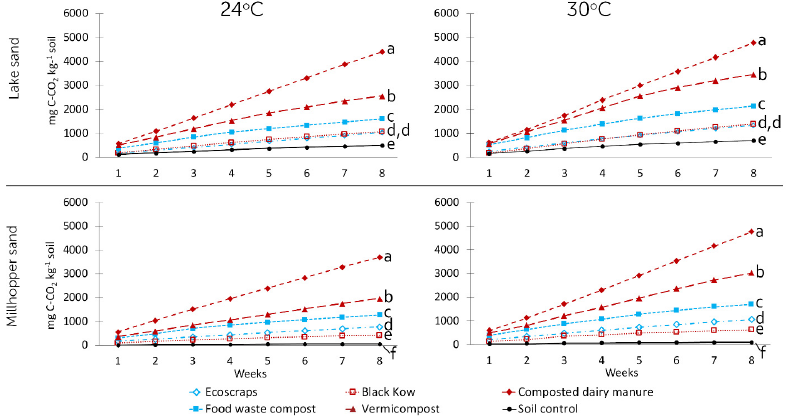
Figure 1. Cumulative C-CO 2 emissions over an 8 week incubation time. Different letters represent significantly different means based on Tukey’s HSD ( α = 0.05) on raw data after 8 weeks of incubation (all ANOVAs: F > 863, p < 0.001). SEs are all below 45 mg C-CO 2 kg − 1 soil.